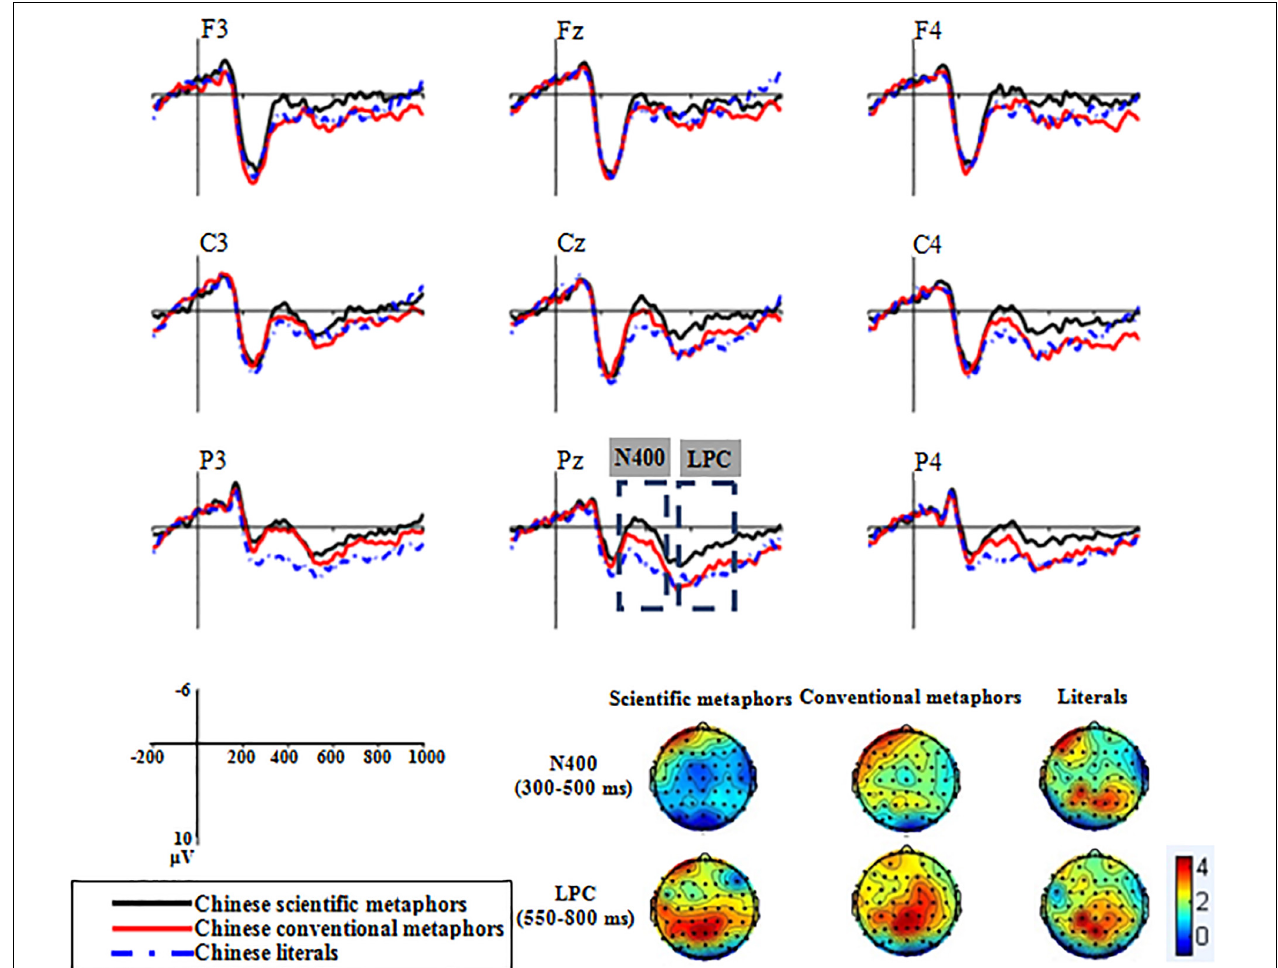
FIGURE 2 | Grand average ERP waveforms of Experiment 1 recorded at the nine chosen